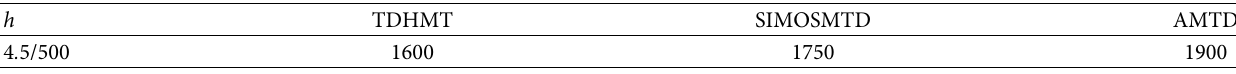
Table 6: Comparison of the NFE of TDHMTwith the NFE of other existing methods, namely, SIMOSMTD and WETMTD for Example 3.